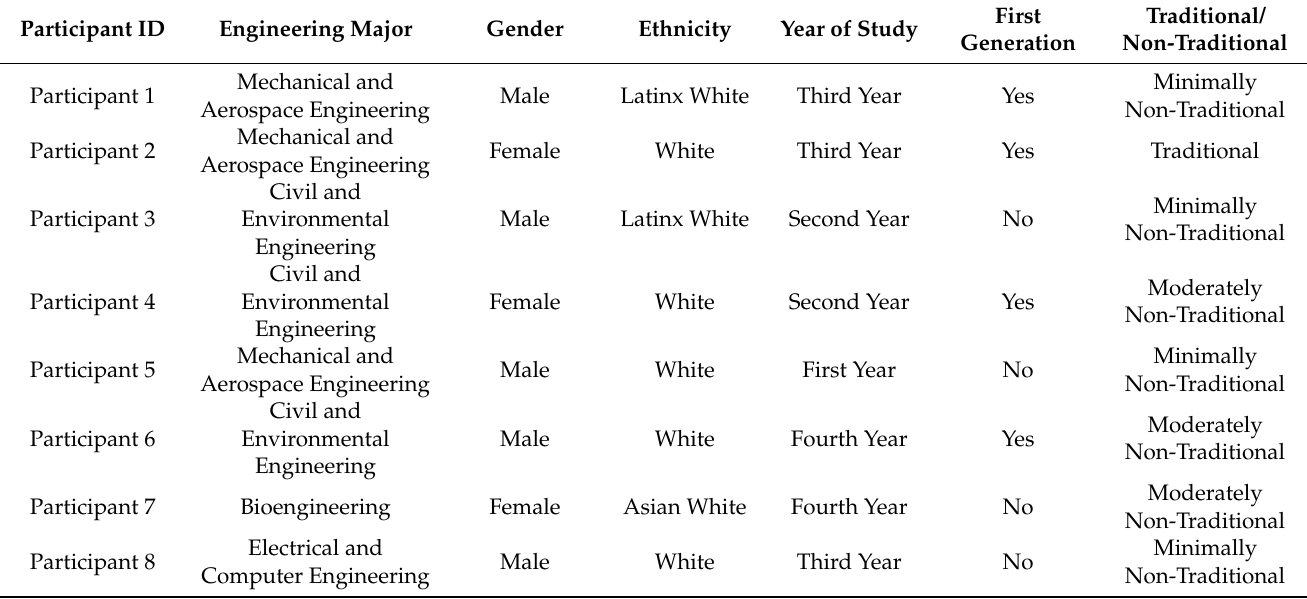
Table 1. Interview participants’